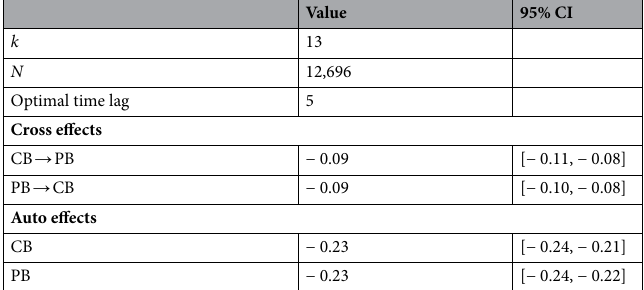
Table 1. Descriptive statistics and results of continuous time meta-analysis (drift coefficients) for the relationship between conspiracy beliefs and COVID-19-related preventive behavior in studies with at least two waves for both constructs. k = Number of independent samples; N = Sample size; Optimal time lag = Time lag (in months) with largest meta-analytic cross-lagged effects (see also Figs. 2 and 3); CB = Conspiracy beliefs; PB = COVID-19-related preventive behavior (e.g., social distancing, wearing masks); For cross effects based on all 17 samples, see the main text (full output is available in supplementary materials).